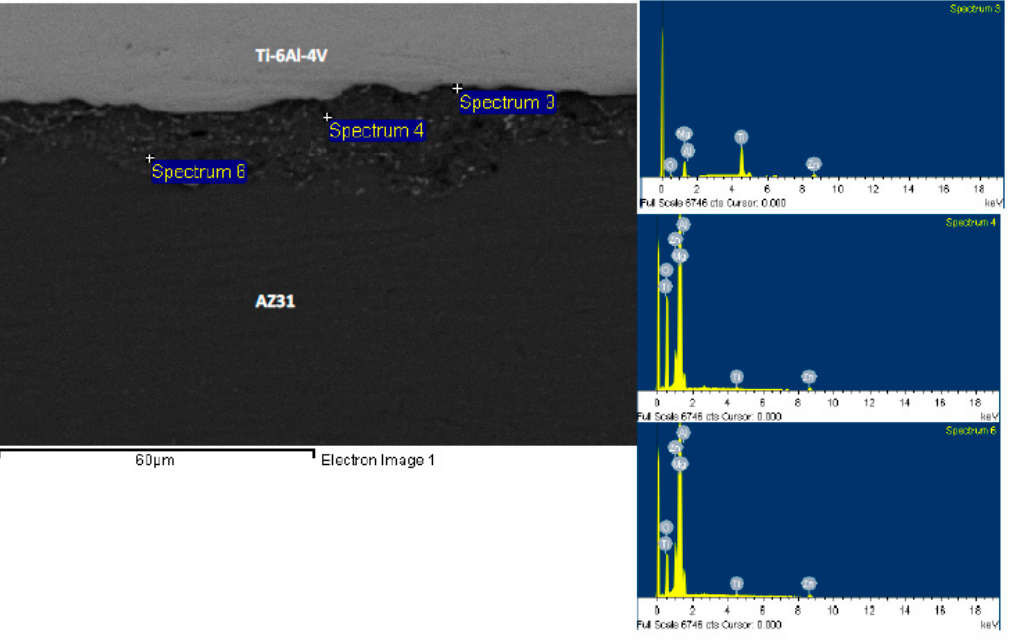
Figure 6. SEM micrograph of the bond made at 30 min and corresponding EDS spot